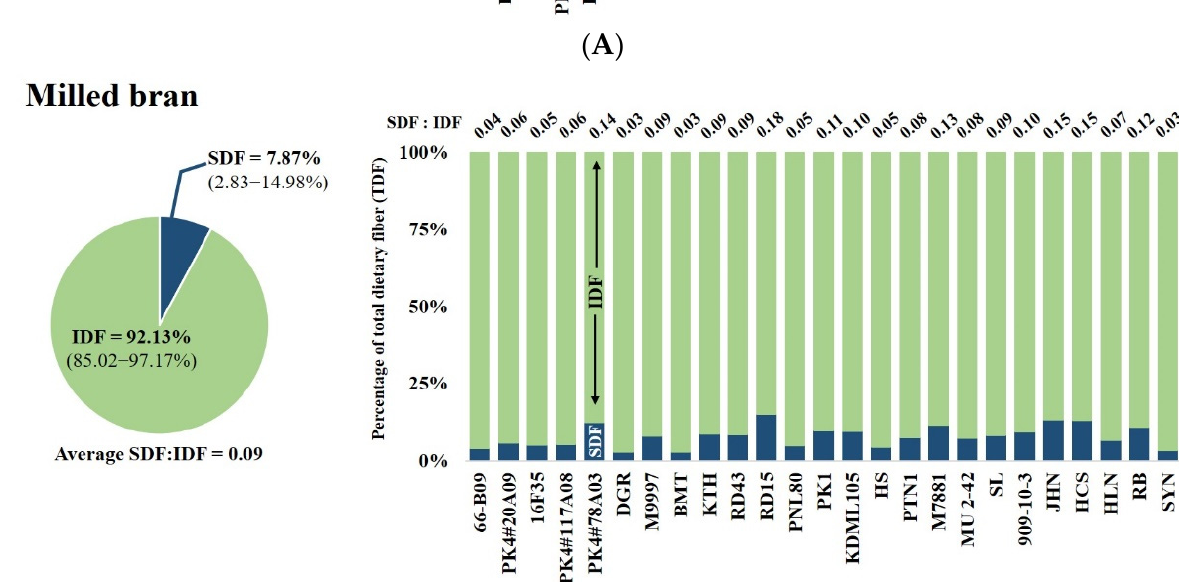
Figure 4. Variation in dietary fibre profiles, SDF and IDF of ( A ) whole grain rice samples with different ACs and ( B ) milled bran samples, expressed as a percentage of TDF.